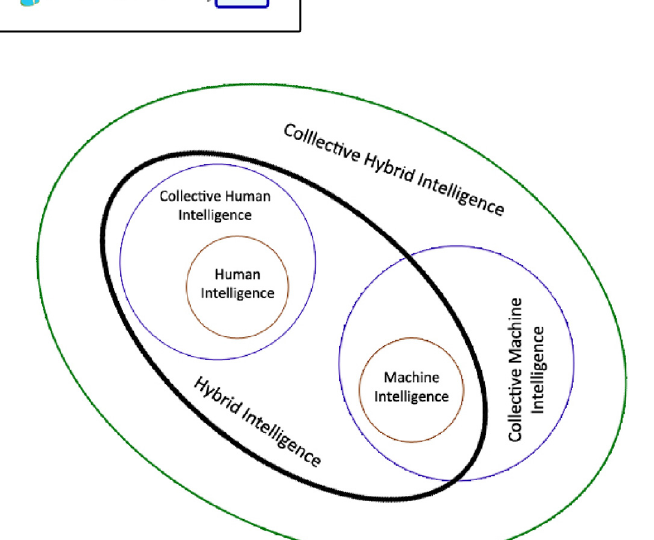
Figure 4. Simpli fi ed schematic of CHI work fl